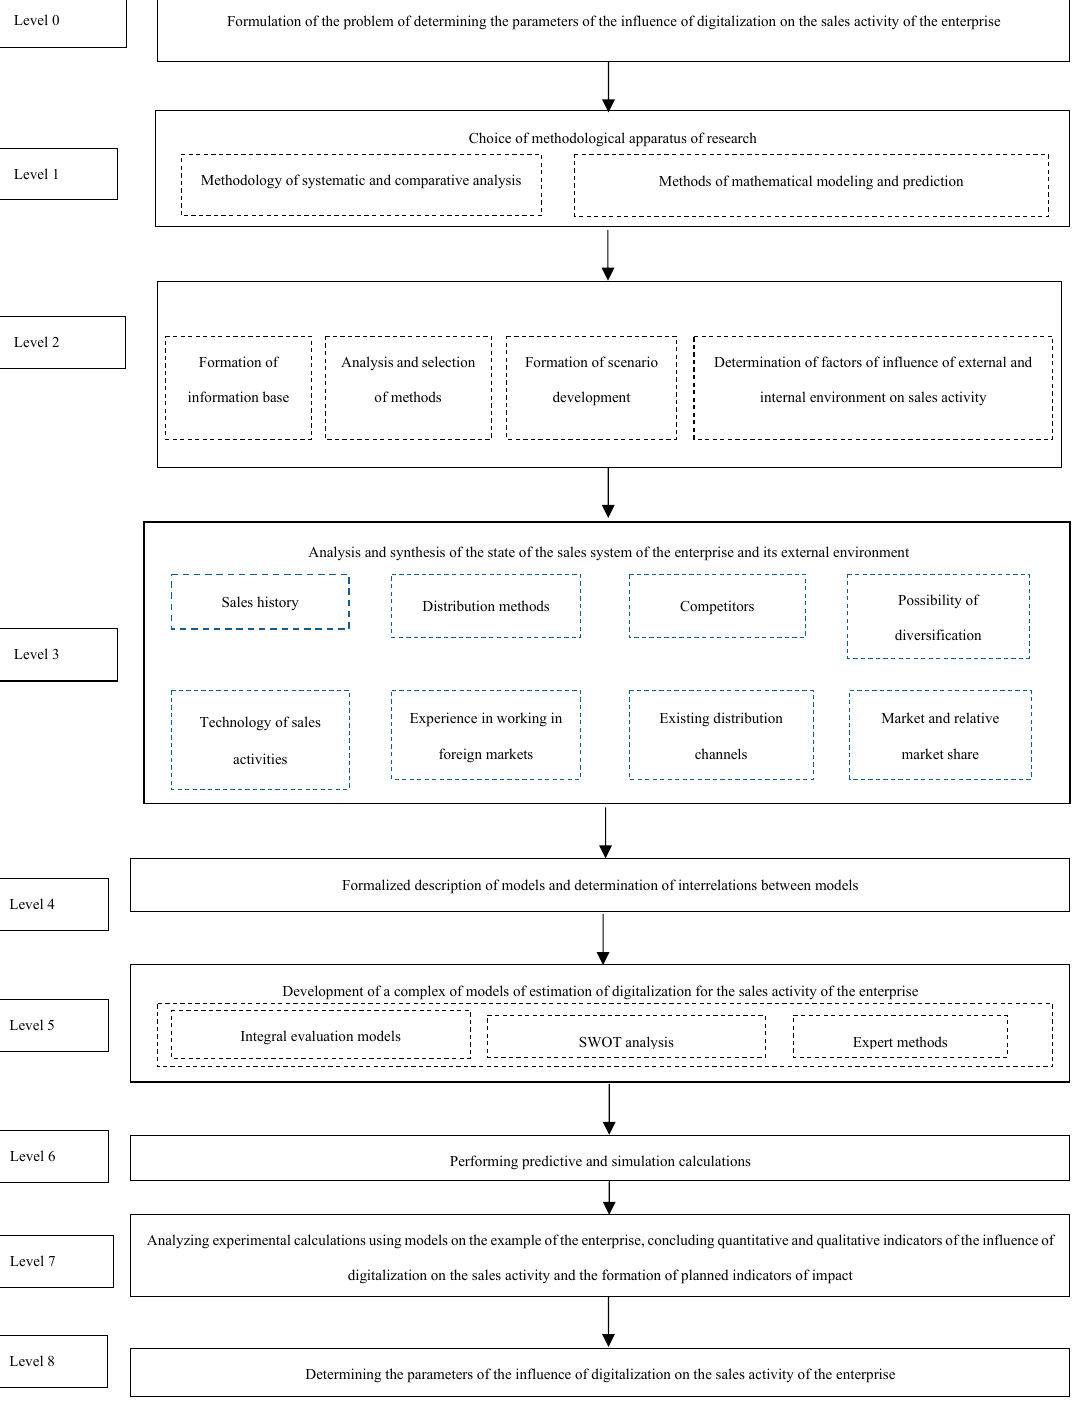
Figure 2. The level system for assessing the influence of digitalization on the sales activity of the enterprise.